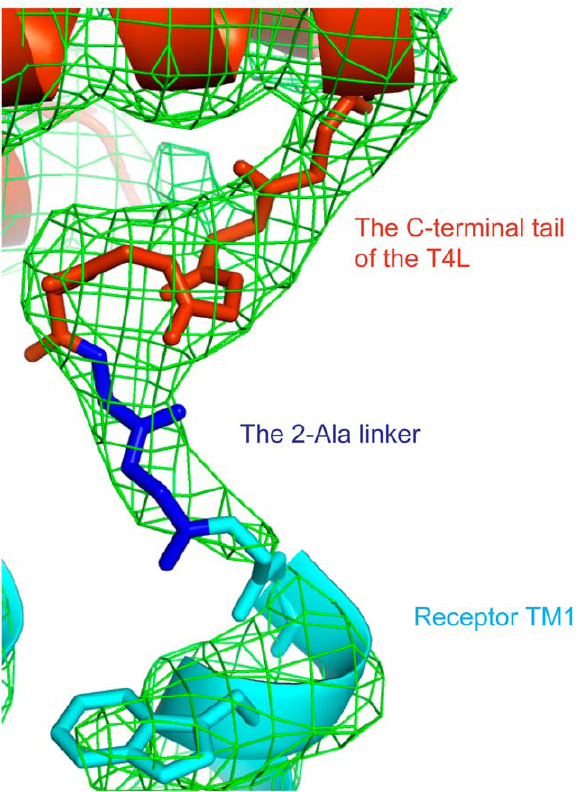
Figure 4. 2Fo-Fc omit map around the 2-Ala linker between T4L and the b 2 AR. The T4L residues Gly156-Tyr161, the 2-Ala linker and the receptor residues D29-E30 are not included in the map calculation. The main chain of the fusion junction is shown in sticks. The electron density is shown in green mesh (0.9 s ). The T4L is shown in orange. The b 2 AR- D ICL3 is shown in cyan. The 2-Ala linker is shown in blue.